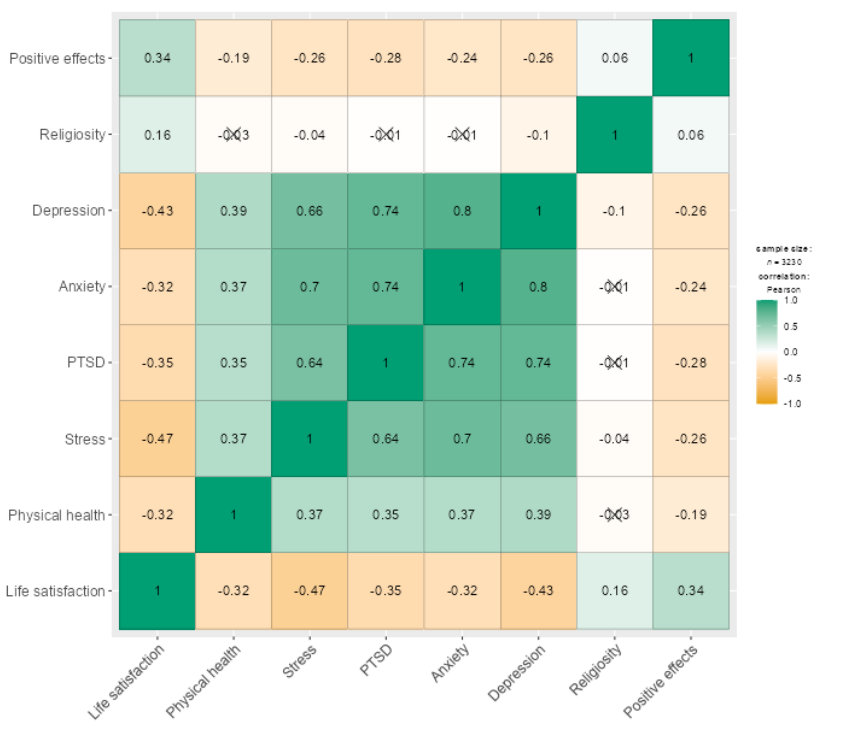
Figure 1. Correlation matrix (heatmap) with Pearson’s r coefficients ( p < 0.05, N = 3230). Note . PTSD = post-traumatic stress disorder related to the COVID-19 pandemic. Deleted coefficients are not sig- nificant ( p > 0.05). Positive correlations (ranging between 0 and +1) are in green, while negative as- sociations (ranging between 0 and − 1) are in orange. The multiple linear regression was conducted to find predictors of life satisfaction among continuous (age, physical health, stress, coronavirus-related PTSD, anxiety, de- pression, religiosity, and positive effects of lockdown) and categorical variables (gender, country, relationship status, PA). The assumptions of regression were acceptable, includ- ing multicollinearity assessed by tolerance (<0.1) and variance inflation factor (VIF < 4), autocorrelation (0.03, Durbin-Watson d = 1.95, p = 0.126), no influential cases biasing the model of regression (Cook’s distance < 1), heteroskedasticity (Goldfield-Quandt = 1.01, p = 0.385), and multivariate normality (Anderson-Darling = 0.48, p = 0.233). The results of the regression are shown in Table 6. All variables are significant predictors of life satisfac- tion except coronavirus-related PTSD. Model can explain 36% of life satisfaction variance, R = 0.60, R 2 = 0.36, F (12, 3217) = 154, p < 0.001.